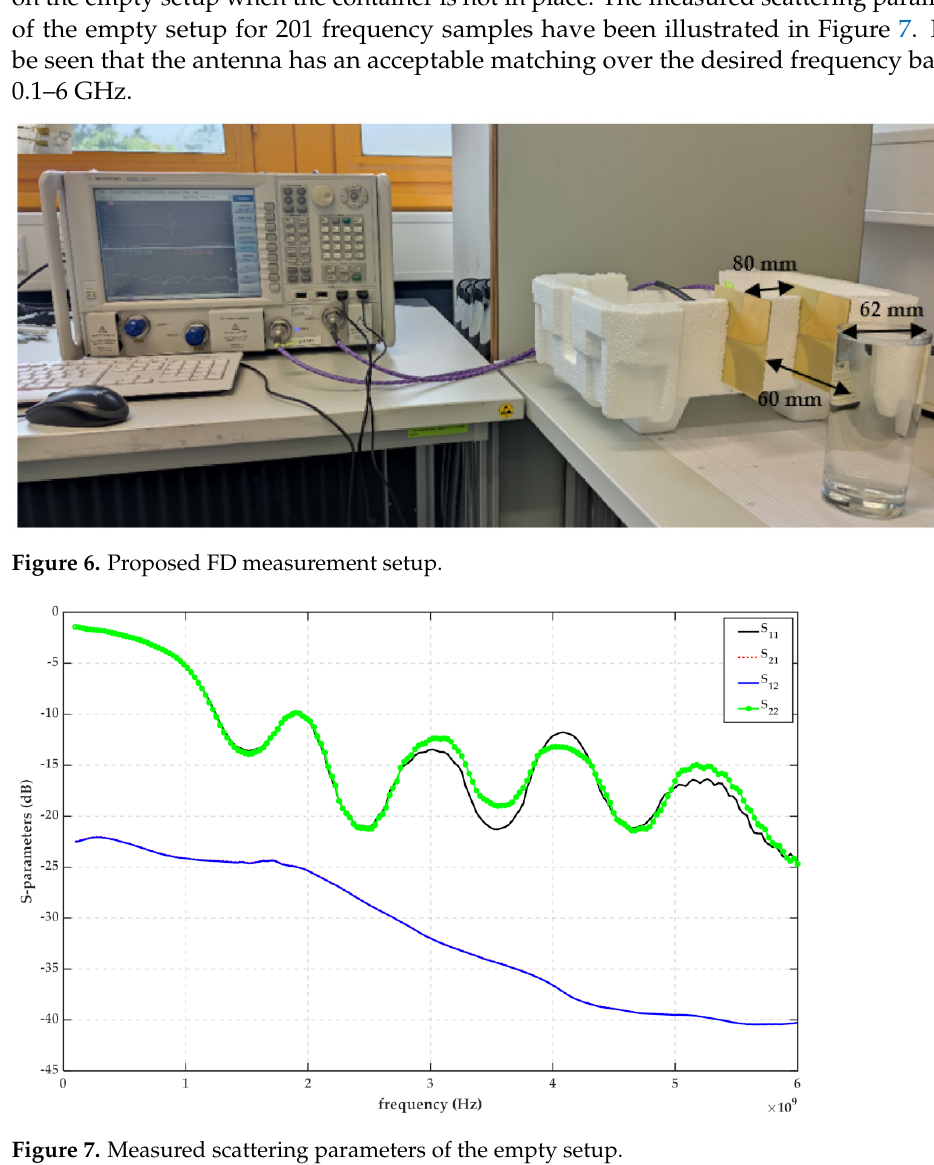
Figure 7. Measured scattering parameters of the empty